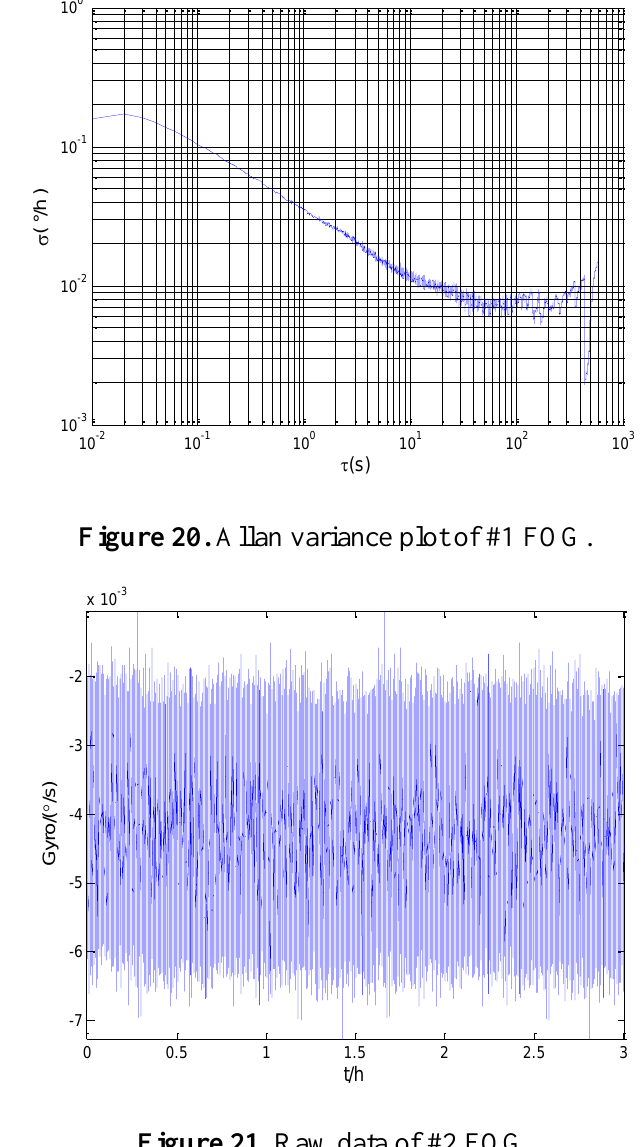
Figure 21. Raw data of #2